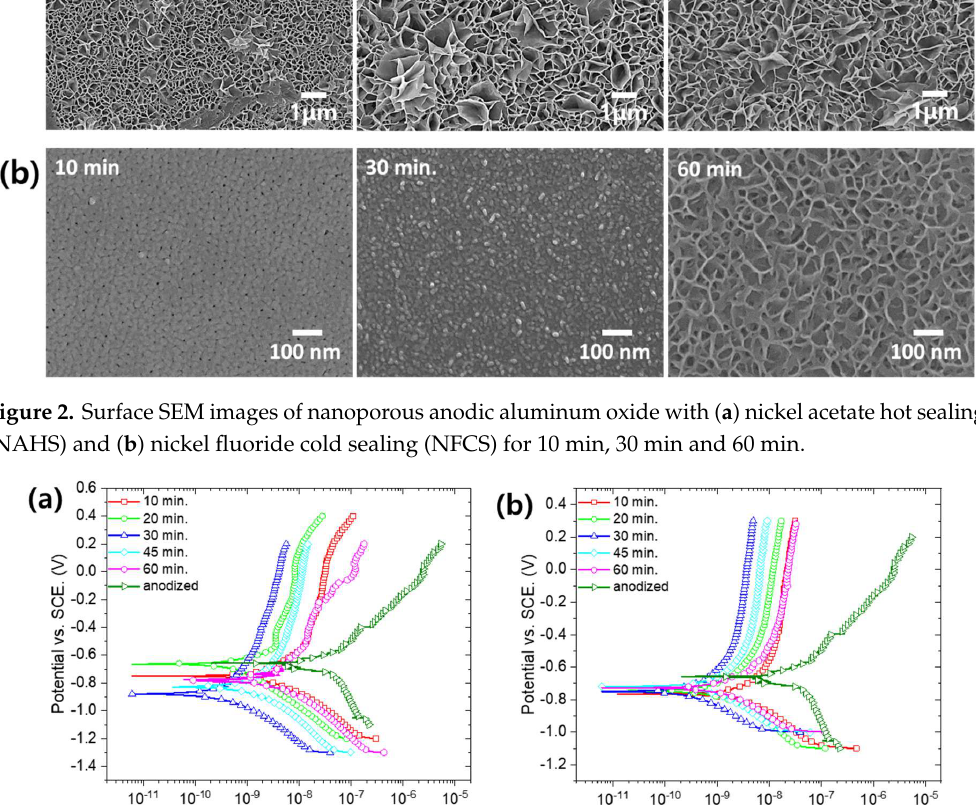
Figure 3. Potentiodynamic polarization curves of anodized aluminum alloy 6061 with ( a ) nickel acetate hot sealing (NAHS) and ( b ) nickel fluoride cold sealing (NFCS).